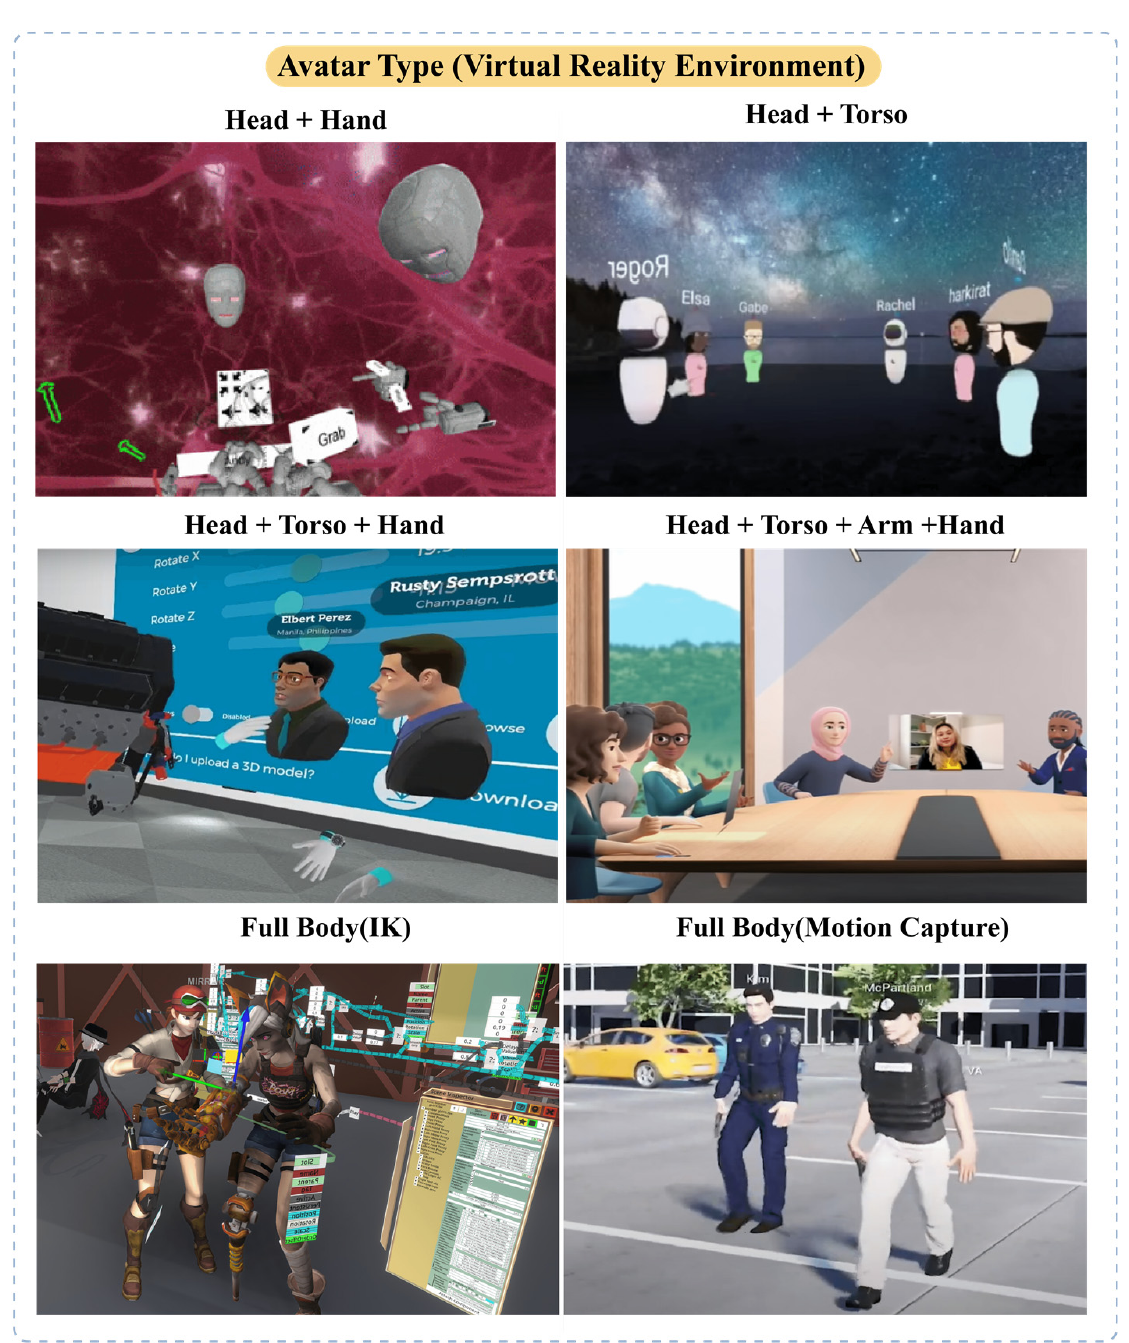
Figure 1. Avatar type (virtual reality environment).